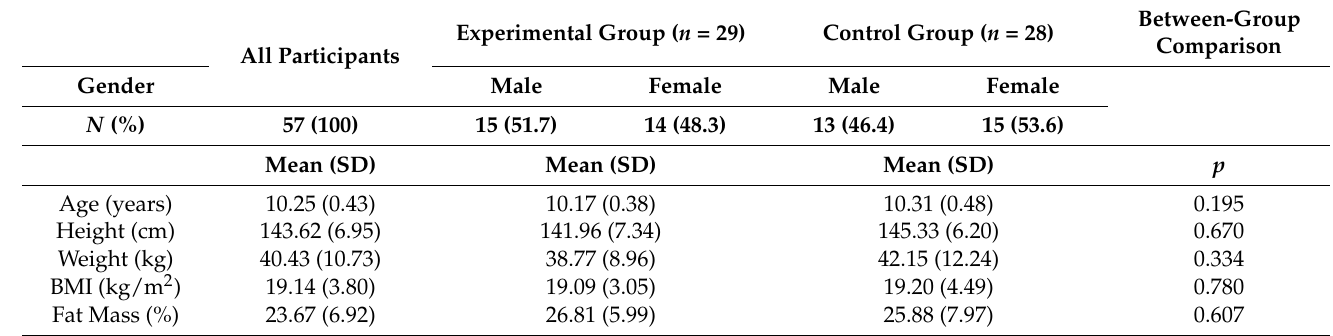
Table 2. Total sample characteristics and stratified by group and